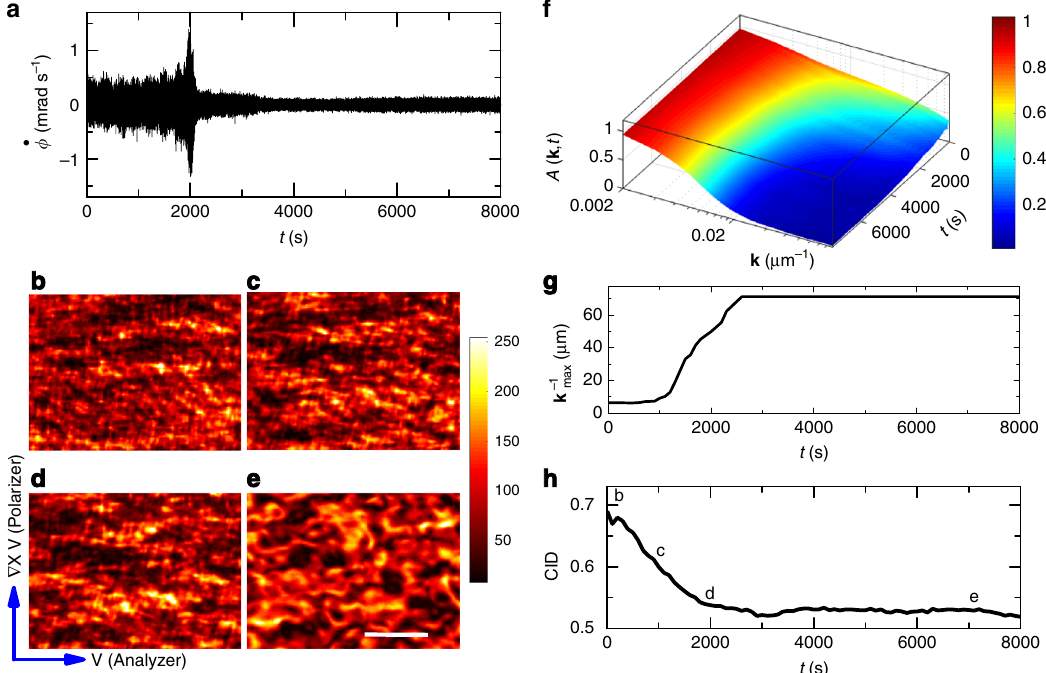
Fig. 4 In situ polarized optical microscopy of domain reorganization in CTAT nematics . a _ ϕ versus t , measured during the rheo-POM experiment with 39 wt % CTAT + water sample at 30 °C ( d ¼ 150 μ m, σ ¼ 2 Pa). POM images obtained at different times b 10 s, c 1000 s, d 2000 s, e 7000 s show coarsening of domains, polarization axis, and fl ow direction are indicated, colors represent intensity level, scale bar has length 50 µ m. f Auto-correlation ( A ð k ; t Þ ) as a function of the wave vector ( k ) for different times, colors represent different A ð k ; t Þ values. g We plot the largest length scale k (cid:3) 1 versus t ; max ; t Þ ¼ 0 : 2. h Computable information density (CID) is plotted with time; b, c, d, e markings are for the images shown above. A ð k ; t Þ and CID where A ð k max for no-shear condition ( σ ¼ 0 Pa) are plotted in Supplementary Fig. structural reorganization is minimal. Another measure of this is We plot CID as a function of time, using L ( t ) the size of the the recently discovered computable information density (CID), images compressed to “ PNG ” format (Fig. 4h). We fi nd that the which is proportional to the losslessly compressed image size 36 . image sizes drop until the system reaches a steady state after CID is de fi ned as CID (cid:6) L ð t Þ = L , where L ( t ) is the size of the the burst. This indicates that the structures are getting bigger in compressed image and L is the original size. All our original size until the main shock appears. Since the POM captures the uncompressed “ BMP ” images are of the same size ( L ¼ 602 KB). orientational order in the system, a larger domain structure